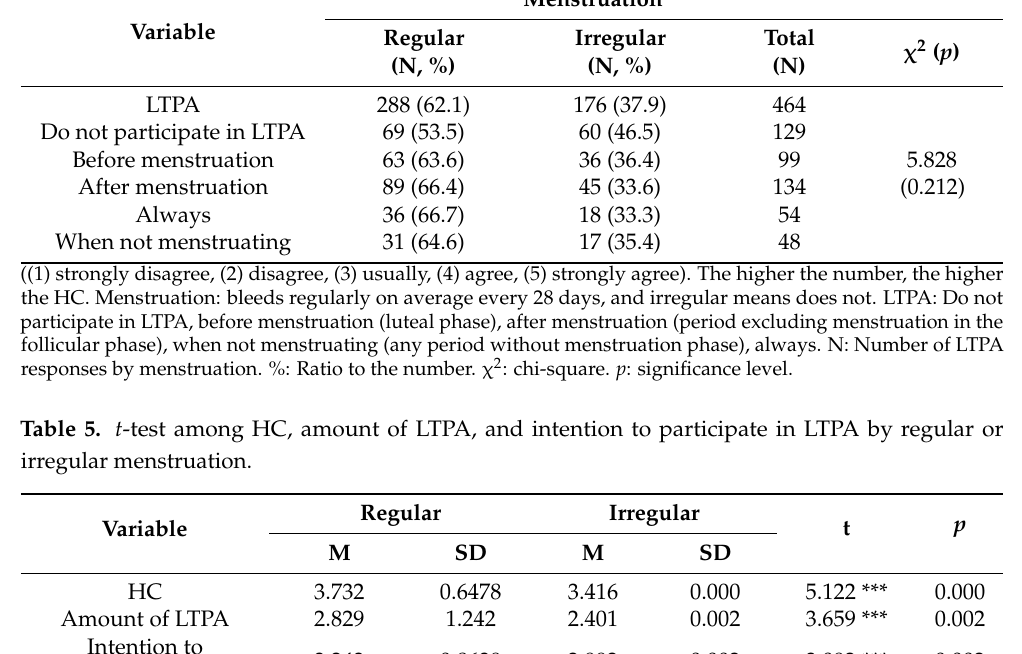
Table 4. Chi-square among LTPA according to menstruation. Menstruation Variable Regular Irregular Total χ 2 ( p ) (N, %) (N, %) (N) LTPA 288 (62.1) 176 (37.9) 464 (0.212)Do not participate in LTPA 69 (53.5) 60 (46.5) 129 5.828 Before menstruation 63 (63.6) 36 (36.4) 99 After menstruation 89 (66.4) 45 (33.6) 134 Always 36 (66.7) 18 (33.3) 54 When not menstruating 31 (64.6) 17 (35.4)